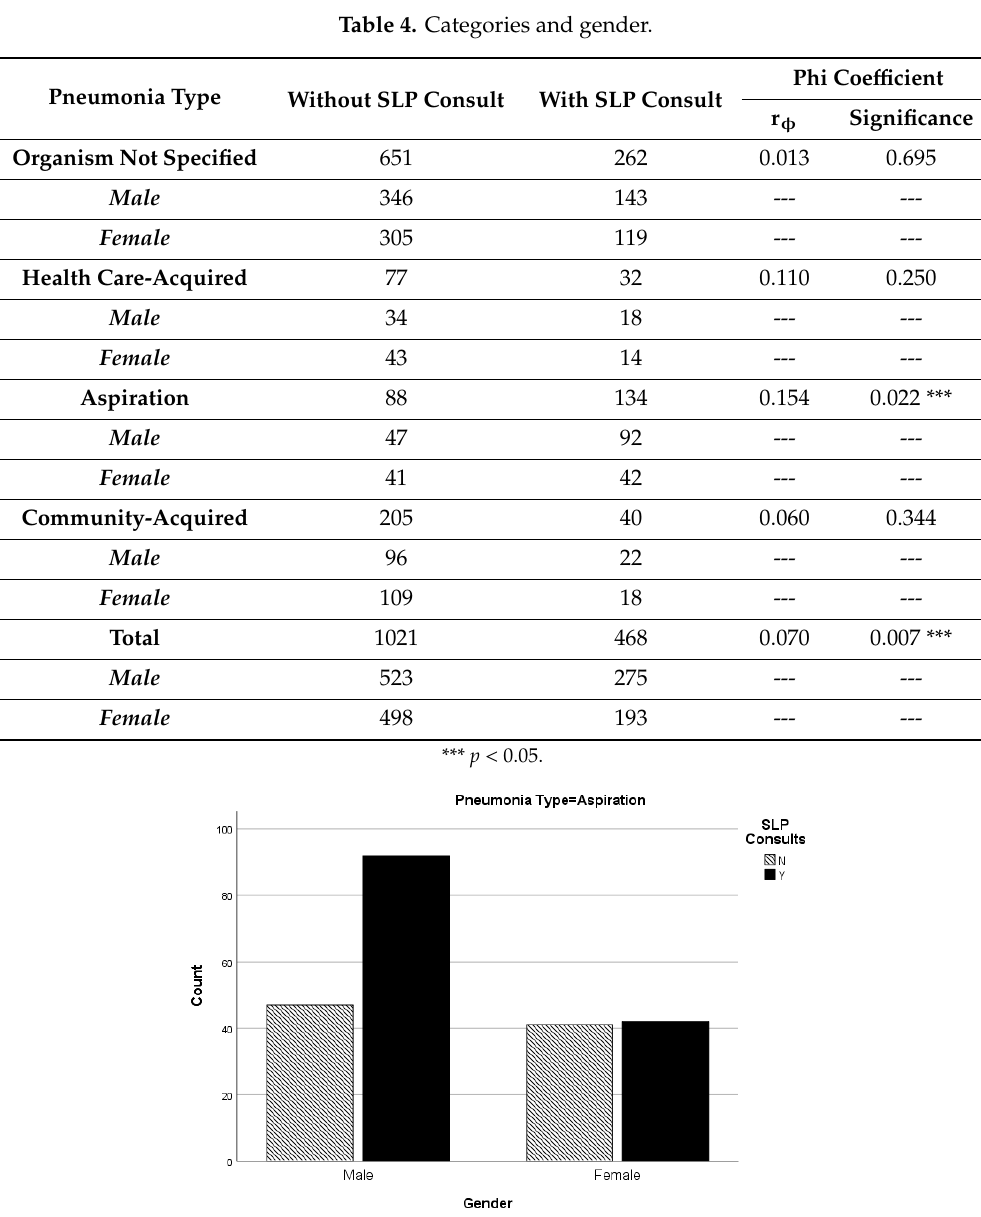
Table 4. Categories and gender.